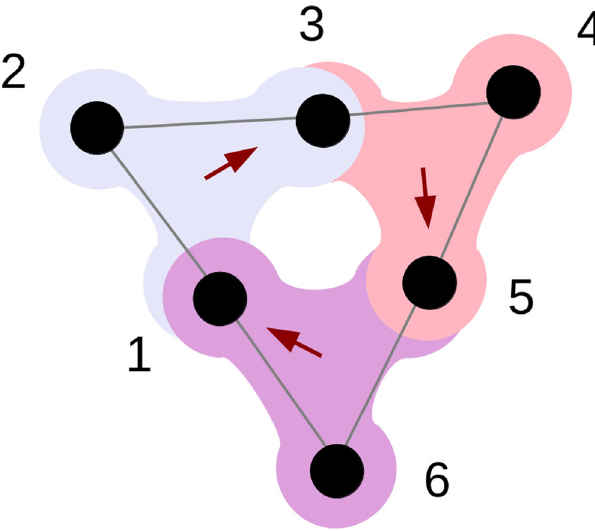
Fig. 7 An example of a weighted 1-directed hypegraph with N = 6 nodes. The arrow indicates the node to which the 1-directed hyperedge points when the symmetrization parameter p (or q) is equal to zero. The different colors of the hyperedges are used to distinguish